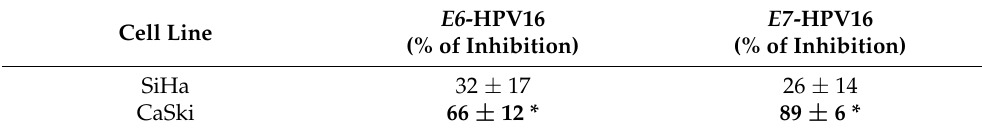
Table 2. The AM inhibitory effects on E6/E7 -HPV16 oncogene mRNA expression. E6 -HPV16 E7 -HPV16 Cell Line (% of Inhibition) (% of Inhibition) SiHa 32 ± 17 26 ± 14 CaSki 66 ± 12 * 89 ± 6 * Effect of α -mangostin (AM) 10 µ M on the percentage of inhibition of E6 - and E7 -HPV16 gene expression, the data of the cells treated with the vehicle were considered as 0% of inhibition. The results are the mean ± SEM of the percentage of inhibition of each oncogene. At least three independent experiments were carried out. The values highlighted in bold were statistically significant. * p < 0.05 vs. vehicle. Table 3. The AM effect upon KCNH1 gene expression in human cervical cancer cell lines. KCNH1 mRNA Inhibition (%) AM ( µ M) SiHa CaSki 0 0 ± 12 0 ± 8 4 16 ± 26 13 ± 18 6 16 ± 19 30 ± 19 * 8 17 ± 30 33 ± 22 * 10 18 ± 19 53 ± 19